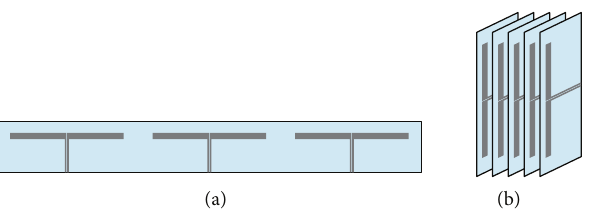
Figure 2: Alignment of antenna elements in linear arrays (a) horizontal on single PCB substrate layer and (b) vertical on individual PCBs for each antenna elements.